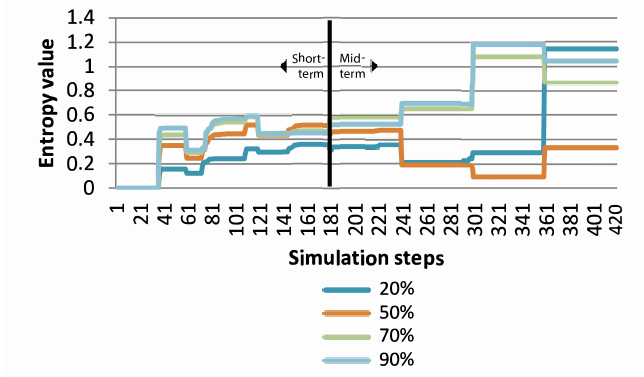
Figure 9. ACO results applying mild SAWs of 72%. Despite the short-term simulations with severe SAWs showing that higher percentages of sites in which SPDOs could make copies had higher resilience, in the mid-term, those executions eventually fell, suffering from instability problems. It can also be appreciated that in the short-term and for mild SAWs, the lower percentages of nodes showed higher resilience, and such a tendency was amplified in the mid-term, where the 20% case showed the best performance. However, and generally speaking, the higher percentages of nodes in which SPDOs could make copies had better values of entropy during almost all of the time of the simulation.